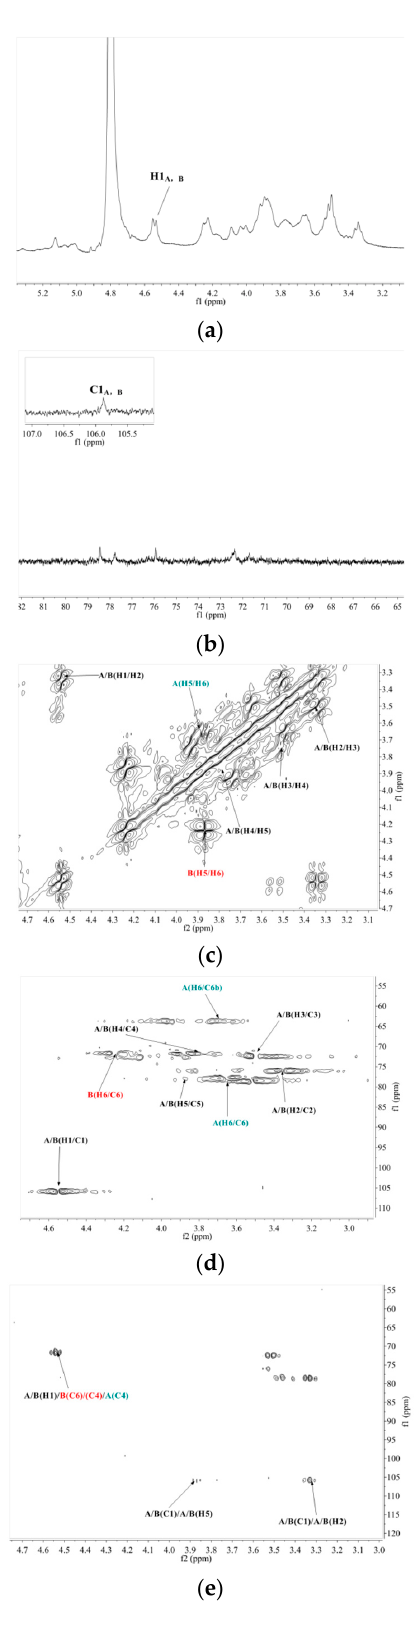
Figure 6. 1 H spectrum ( a ); 13 C spectrum ( b ); COSY spectrum ( c ); HSQC spectrum ( d ); HMBC spectrum ( e